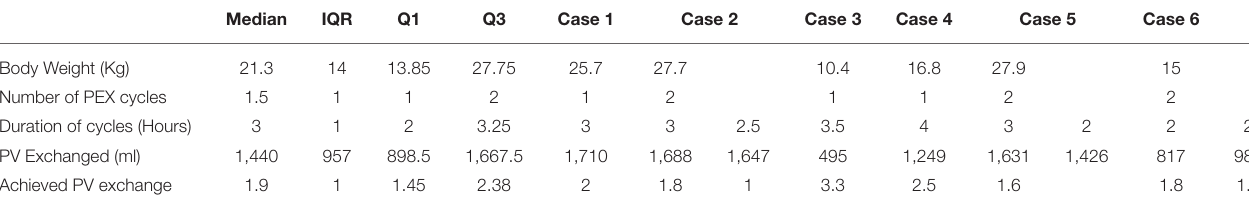
PV Exchanged (ml)